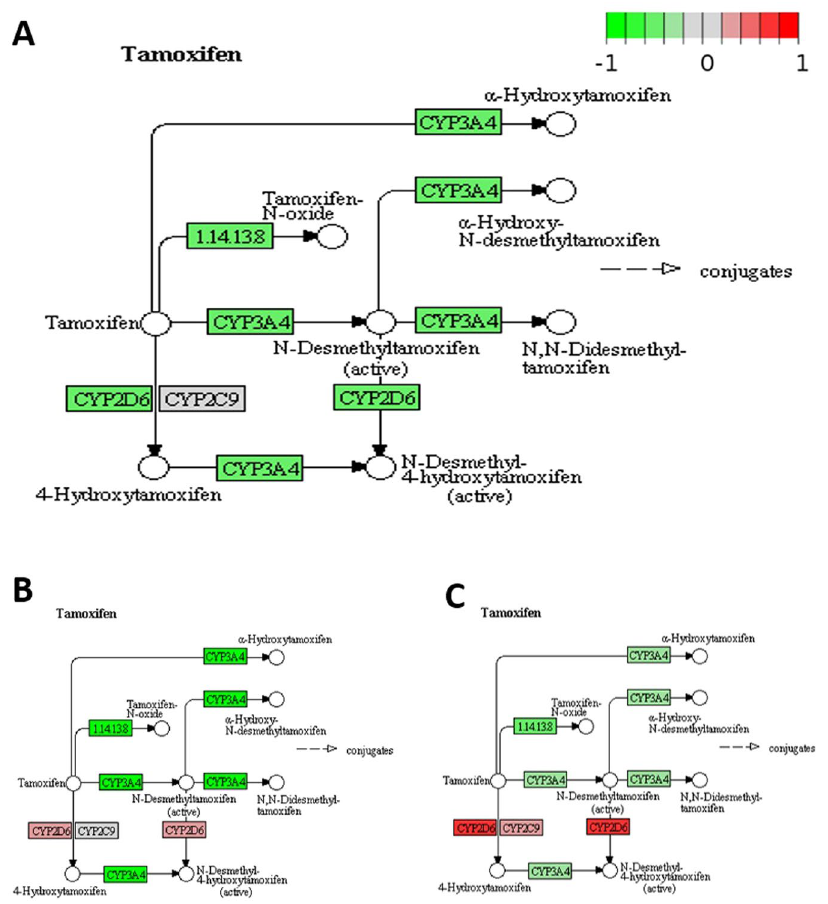
Figure 3. Differential gene expression in the tamoxifen metabolism pathway. ( A ) Asian American vs African American. Up or down regulation means increase or decrease of gene expression in Asian American BRCA patient tumor tissues. ( B ) Asian American vs Caucasian American. Up or down regulation means increase or decrease of gene expression in Asian American BRCA patient tumor tissues. ( C ) African American vs Caucasian American. Up or down regulation means increase or decrease of gene expression in African American BRCA patient tumor tissues. The pathway diagrams with differential gene expression were made using Pathview package 47 , where pathway diagrams were originally obtained from KEGG database 18–20